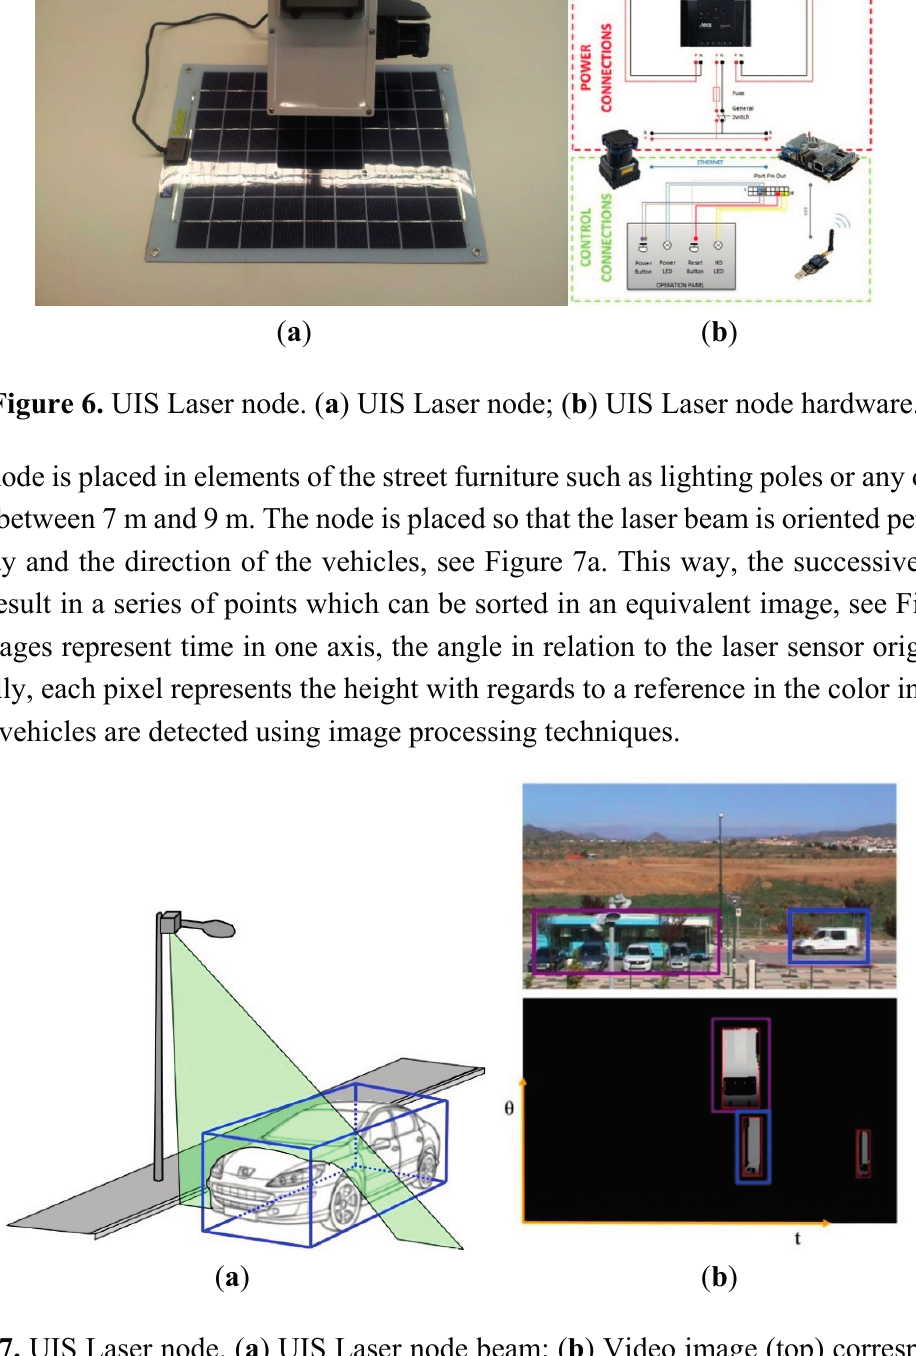
Figure 7. UIS Laser node. ( a ) UIS Laser node beam; ( b ) Video image (top) corresponding to a laser node image